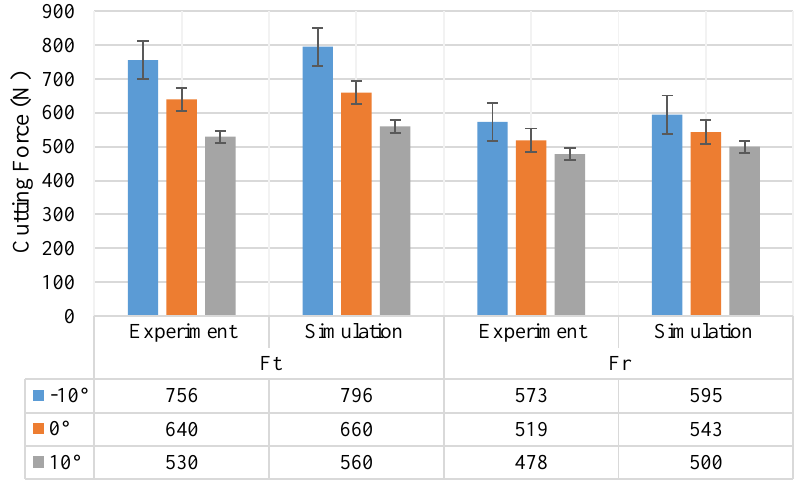
Figure 6. Comparison of simulated cutting force and experimental cutting force.